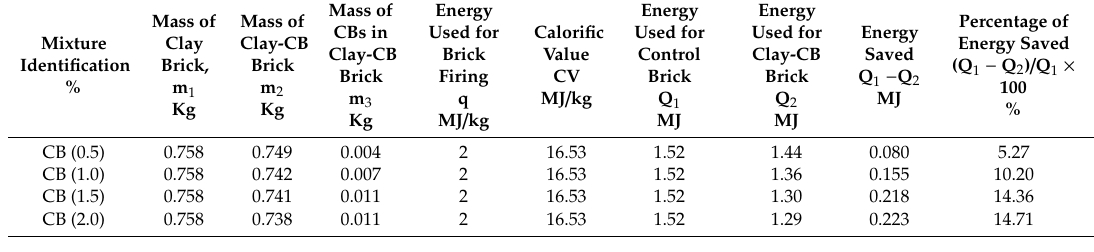
y = 6.4951x + 3.017